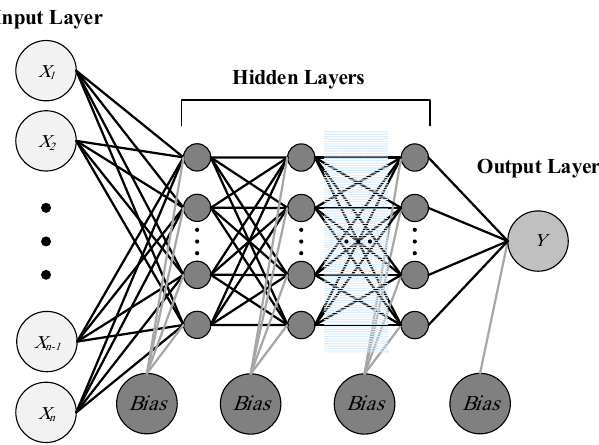
Figure 4. Schematic of ANN algorithm.